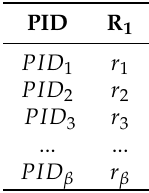
Table 4. R-value